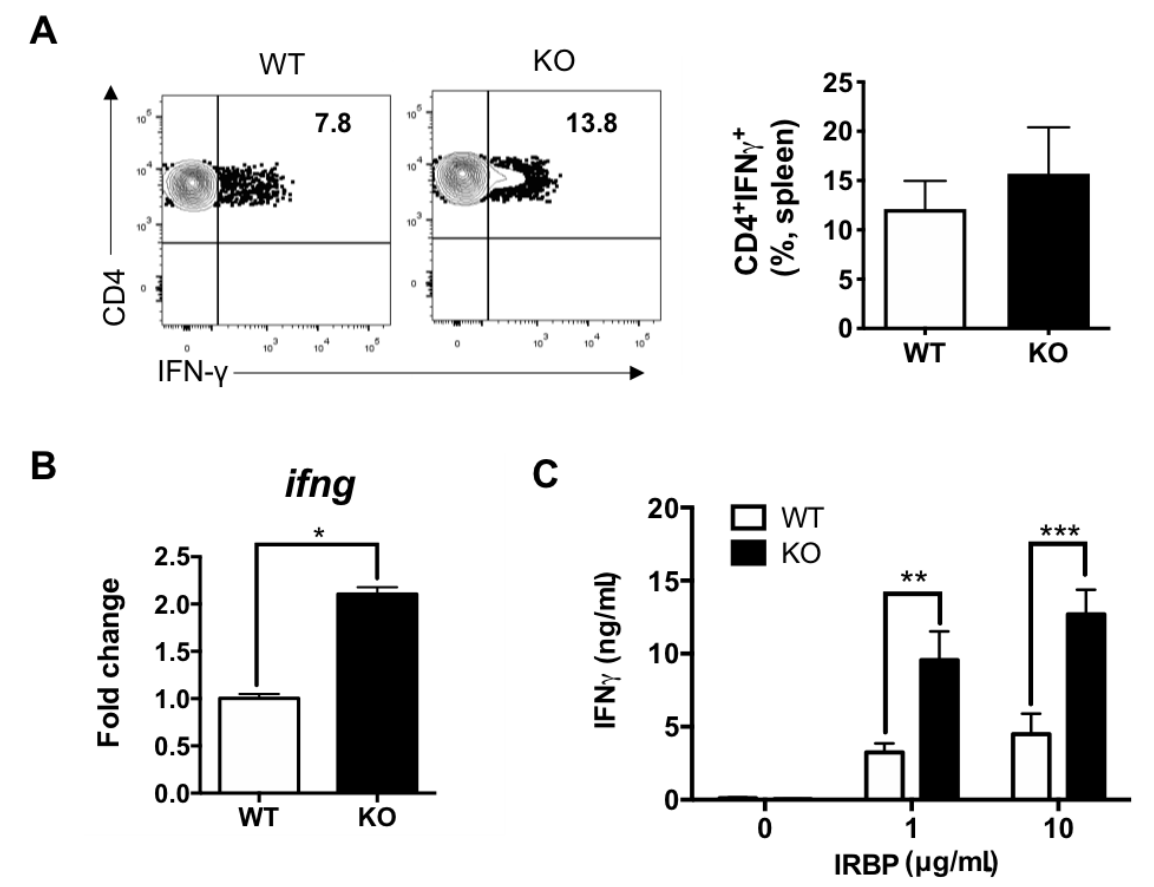
图 3 Figure 3. Peripheral Th1 response increased in IL-27Ra − / − EAU mice. ( A ) Representative plots and frequency of IFN- γ - producing CD4 + T cells in the spleens from WT and KO EAU mice. Data represent the means ± SEMs of two experiments (WT: n = 5 mice; KO: n = 7 mice). ( B ) The relative gene expression of ifng in CD4 + T cells. Total RNA was extracted from CD4 + T cells that were sorted from the spleens of WT and KO EAU mice on day 21 post-immunization. Data represent the means ± SEMs from a representative of two independent experiments (4 mice per group). * p < 0.05, Mann–Whitney U test. ( C ) Retinal antigen-specific IFN- γ production in dLNs of WT and KO EAU mice. Lymphocytes were isolated from dLNs and stimulated with IRBP for 48 h. Cultured supernatants were collected for cytokine determination by ELISA. Data represent the means ± SEMs of two experiments (WT: n = 5 mice; KO: n = 6 mice). ** p < 0.01, *** p < 0.001, two-way